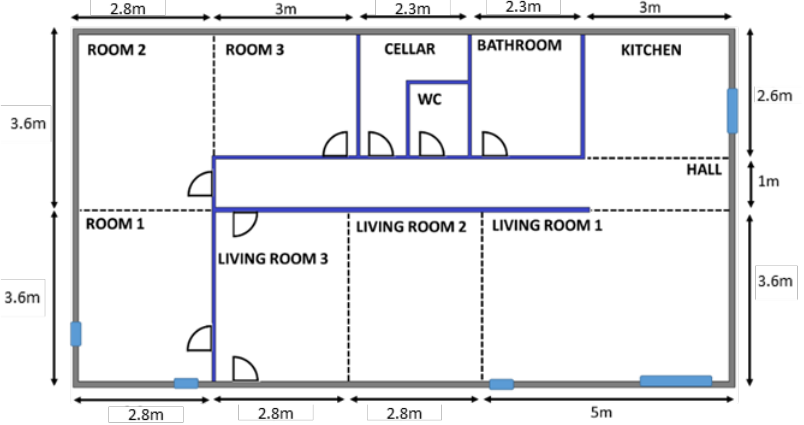
Figure 2. Plan of the test chamber (view from above).